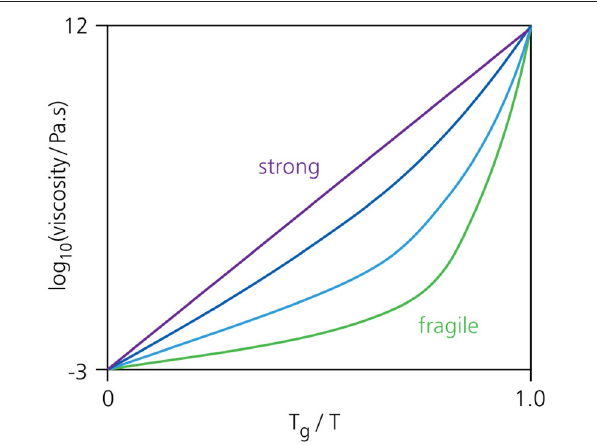
FIGURE 2 | Typical fragility plot, showing the logarithm of the viscosity as a function of inverse temperature 1 / T , normalized with respect to the glass transition temperature T g . A viscosity of 10 − 3 Pa.s corresponds to a normal liquid, while a value of 10 12 Pa.s defines a glassy solid. So-called strong glass formers such as silica exhibit an Arrhenius-type growth of the viscosity upon cooling, while fragile glass formers such as o -terphenyl show a much steeper temperature dependence close to T g . Many materials, including colloidal hard spheres and confluent cells, fall in between these two